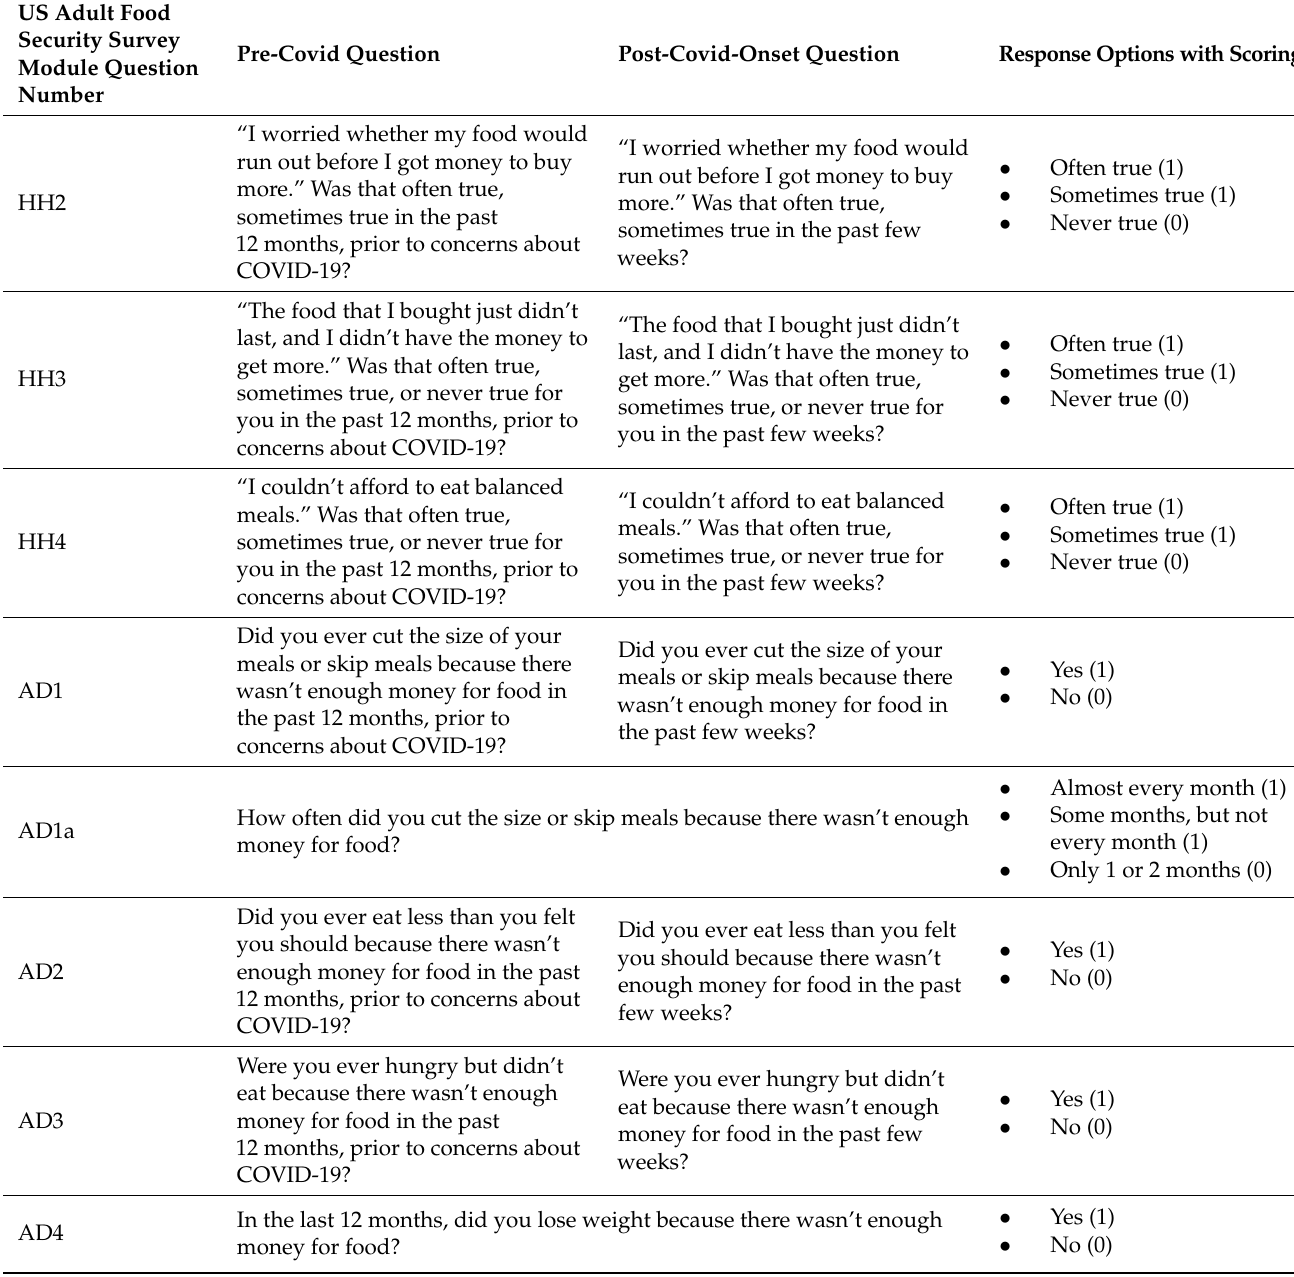
Table 1. Food Security Survey